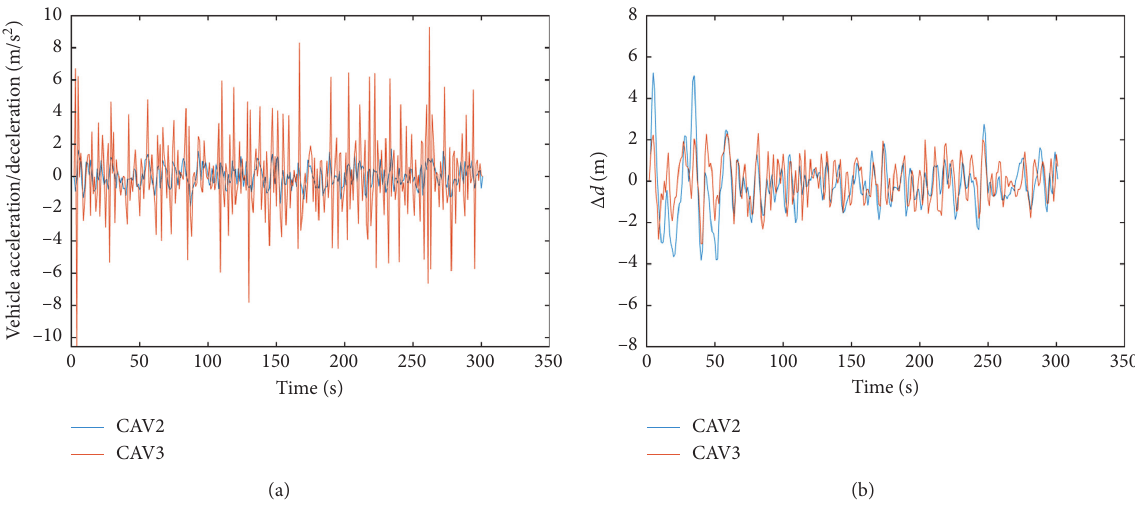
Figure 14: The fleet control under high stability requirement. (a) The acceleration of CAVs. (b) The control error of